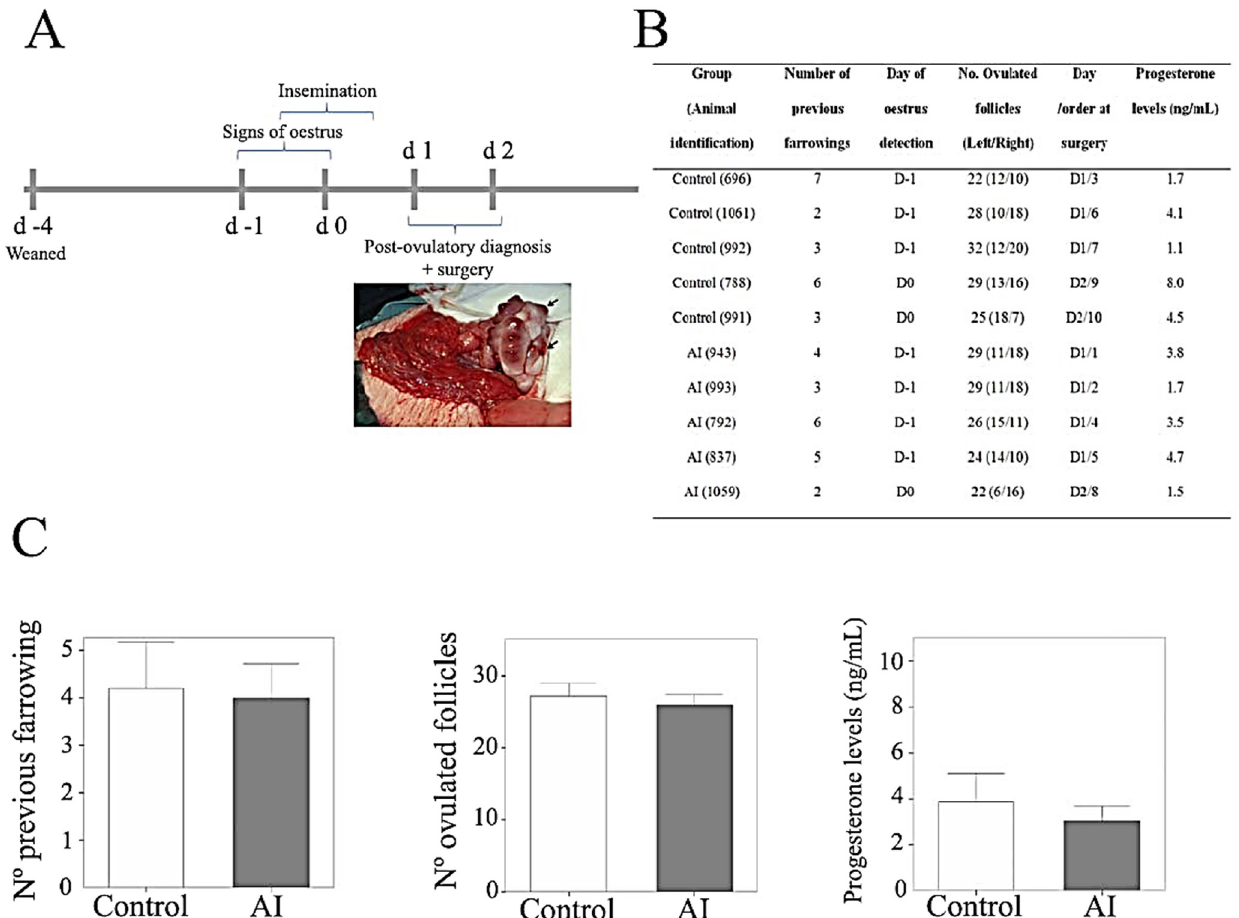
Fig 1. (A) Representative diagram of the experimental protocol for the recovery of the oviductal tissue samples and image of the left ovary of sow number 5, showing the recently ovulated follicles as corpora haemorrhagica (arrows). (B) Animal dataset. (C) Comparative histograms of physiological data for inseminated and non-inseminated